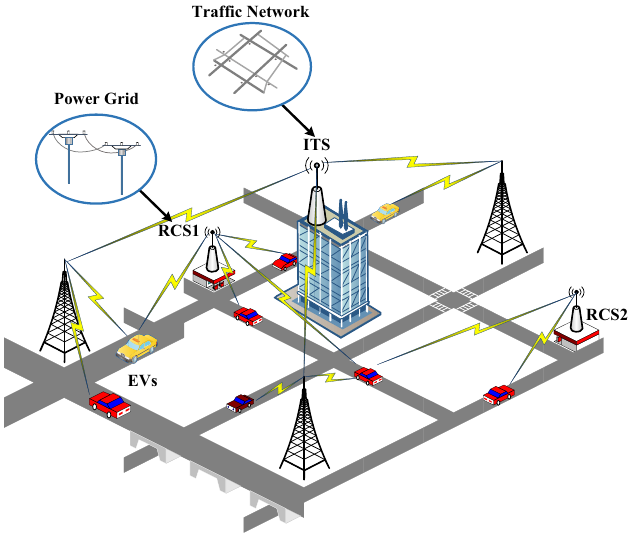
Figure 1. System model overview.